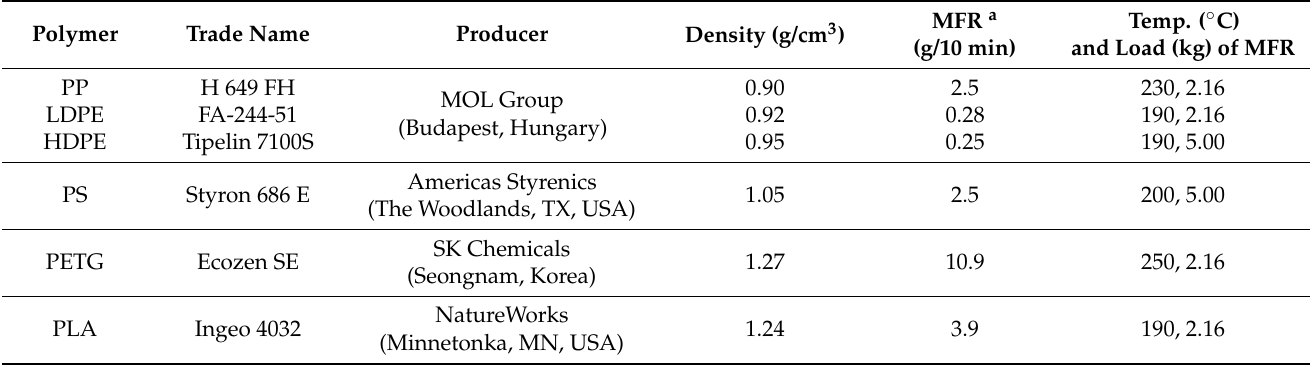
Table 1. The most important properties of the matrix polymers used in the experiments.